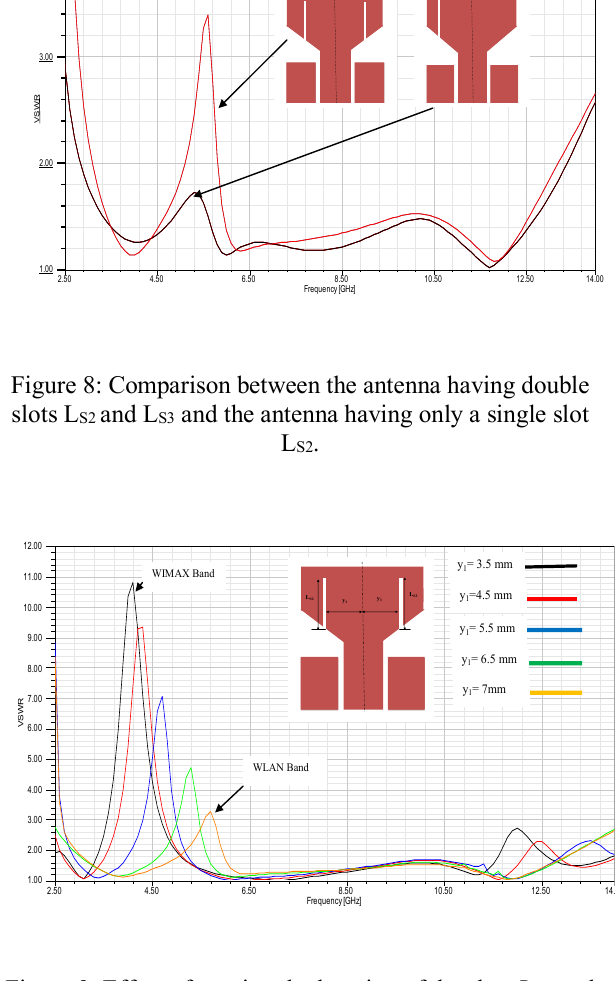
Figure 9: Effect of varying the location of the slots L S2 and L S3